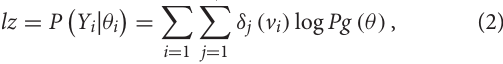
Frontiers in Psychology |